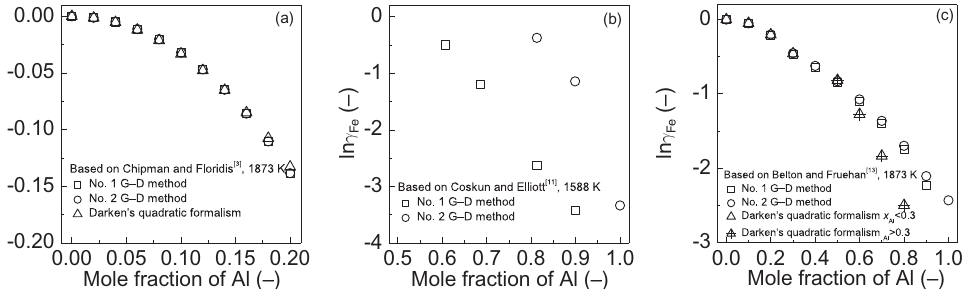
of Fe based on activity coefficient ln γ of Al by No.1 and No.2 Gibbs – Fe Al